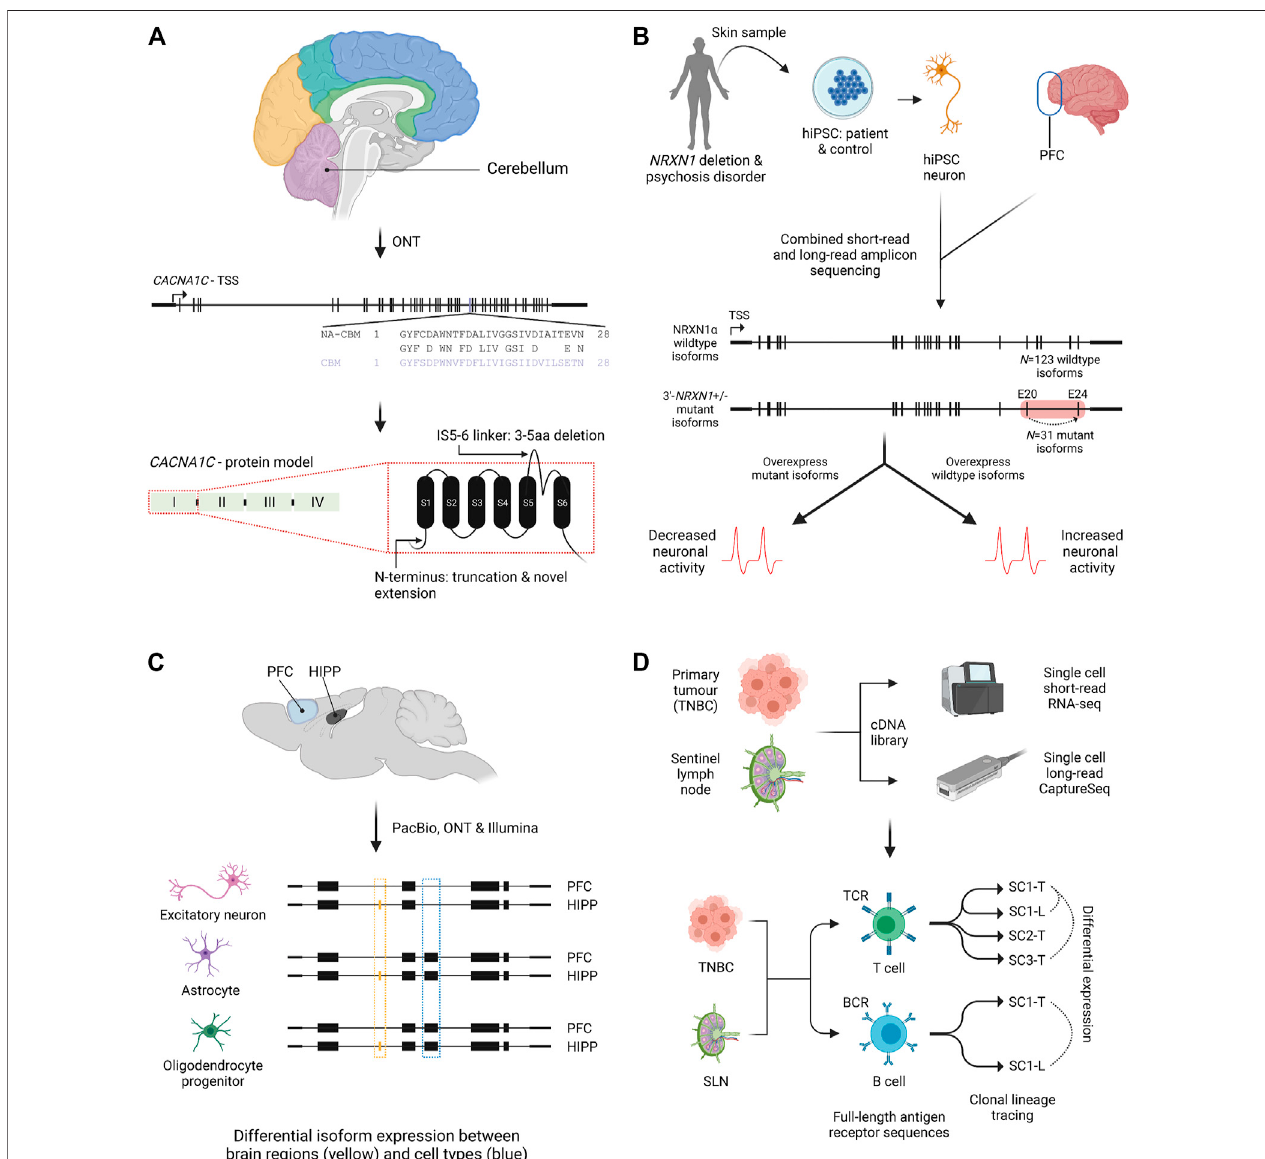
FIGURE3| Isoformcharacterisationinhealthanddisease. (A) Nanoporeampliconsequencingof CACNA1C inpost-mortemhumanbrainfoundanisoformswitch incerebellum(purple)forexon30comparedtonon-cerebellartissues.AnexampleofnovelsplicingimpactsontheN-terminusandanextracellularregion(IS5-6linker)is also shown for the fi rst CACNA1C protein domain (Clark et al., 2020). NA-CBM, non-cerebellar tissue; CBM, cerebellum; aa, amino acid. (B) Combined short and long- read amplicon sequencing of NRXN1 α in PFC and NRNX1 mutant and wildtype hiPSCs characterised expressed isoforms. Overexpression of mutant isoforms in wildtype hiPSCs or wildtype isoforms in mutant iPSCs identi fi ed genotype dependent impacts on neuronal activity. Red box indicates location of patient speci fi c NRXN1 α +/- deletions. Dashed arrow indicates exon skipping from exons 20 to 24 (Flaherty et al., 2019). PFC, prefrontal cortex; hiPSC, human induced pluripotent stem cell; TSS, transcriptional start site. (C) Single cell isoform RNA sequencing (ScISOrSeq) from mouse prefrontal cortex and hippocampus identi fi ed cell type signatures, e.g., exon exclusion (blue box) and tissue speci fi c signatures e.g. exon inclusion in hippocampus (orange box) (Joglekar et al., 2021). PFC, prefrontal cortex; HIPP, hippocampus. (D) Repertoire and Gene Expression by sequencing (RAGE-Seq) characterised full-length antigen receptor sequences for T and B cells from a primary tumour (breast) and its sentinel lymph node. Clonal lineages and clonal expansions were identi fi ed, as well as differential expression between clonally expanded T